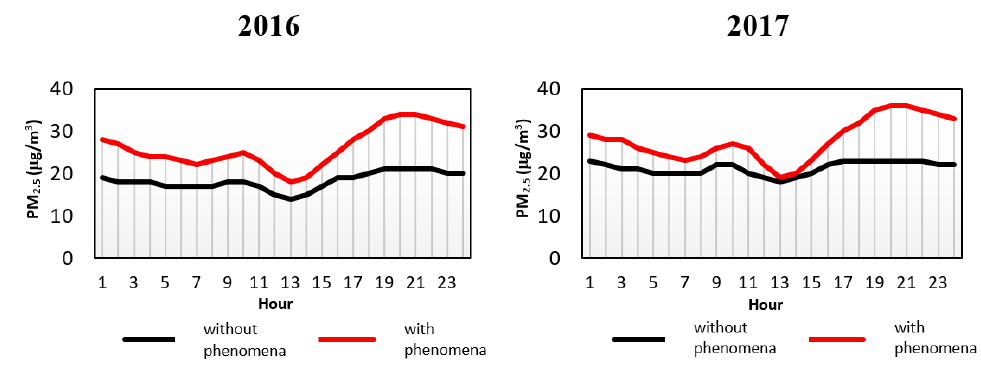
Figure 5. The mean hourly PM 2.5 value observed at Puli EPA supersite for the days with or without the plausible meteorological phenomena causing temperature inversion.